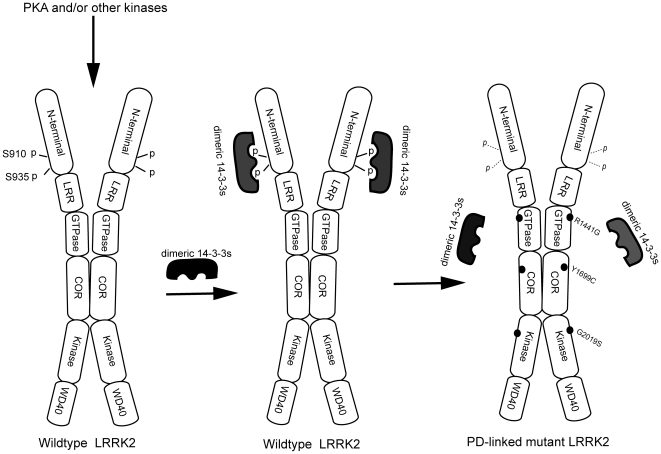
PKA Phosphorylation, 14-3-3 binding of LRRK2, and the effect of common familial mutations of LRRK2 in 14-3-3 binding.A schematic model showing PKA (or other kinase) phosphorylation of S910/S935, dimeric14-3-3 binding of LRRK2 at pS910/pS935 sites in wild type LRRK2; PD-linked mutations R1441G, Y1699C or G2019S abolishes or reduces phosphorylation of S910/S935 and impairs 14-3-3 binding. In addition, we propose that dimeric 14-3-3 bind to pS910 and pS935 in the same LRRK2 molecule and binding of 14-3-3 plays little role in LRRK2 dimer formation.